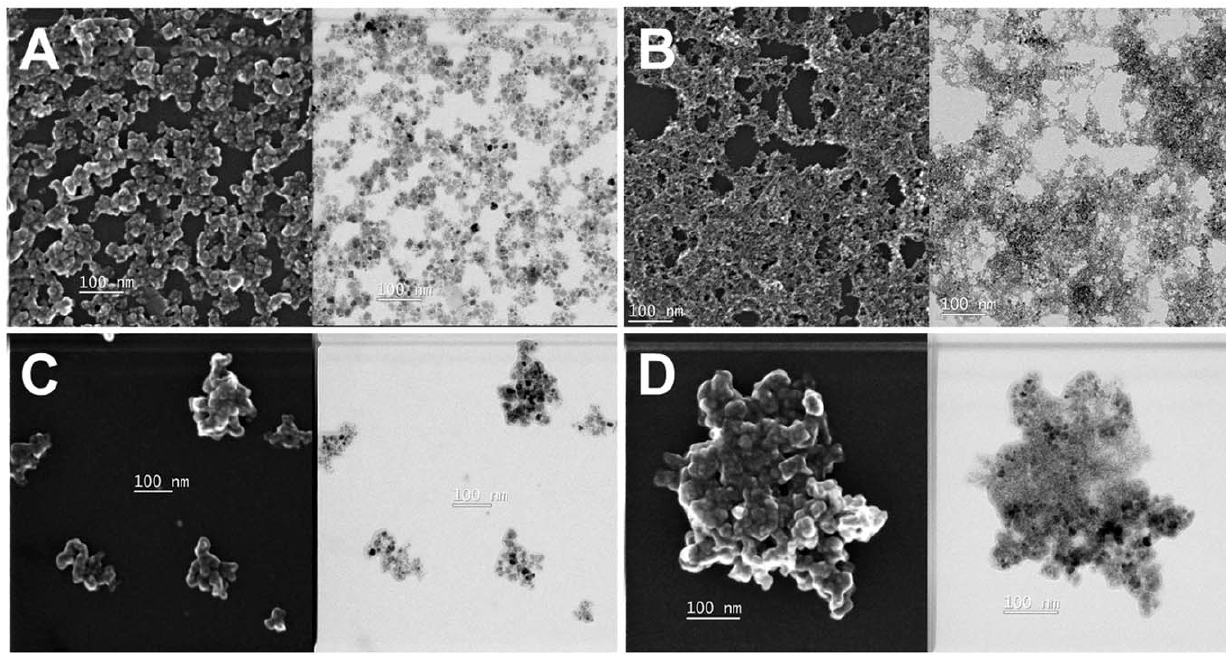
Figure 4. SEM and TEM spectra. SEM (left) and TEM (right) images of A: the IONPs; B: the CS-IONPs composites; C: the adhesive CCS-IONPs composites; D: the adhesive CCS-IONPs composites after enzyme immobilization.